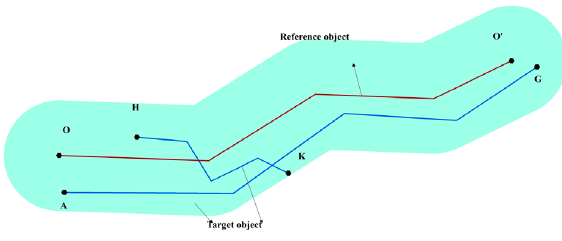
Fig. 8. Buffer surrounding of reference